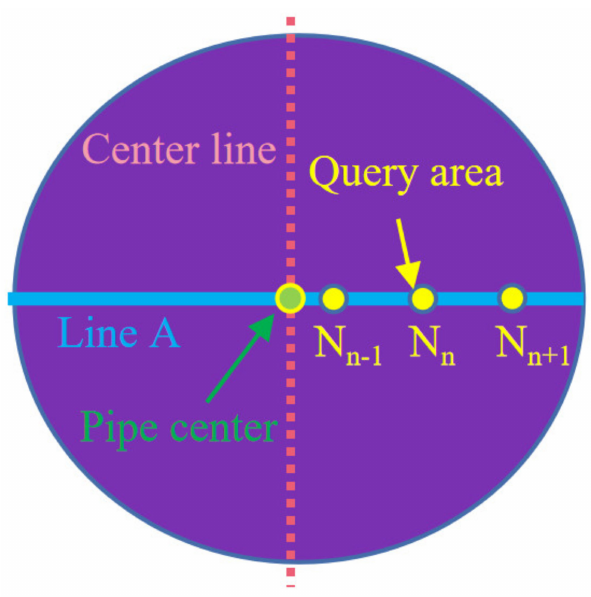
Figure 1. Loop integral diagram.